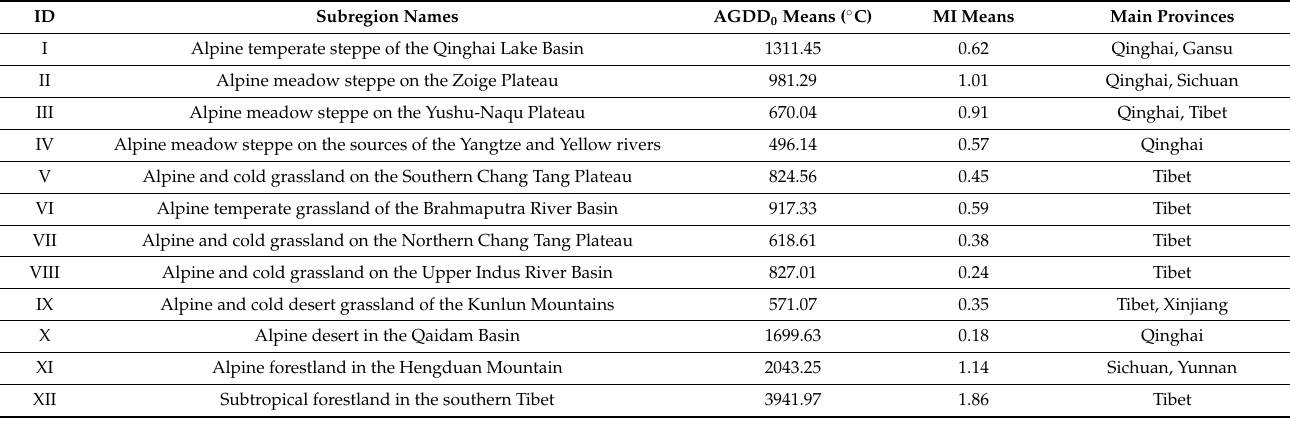
Table 1. Description of the Qinghai-Tibetan Plateau subregions. AGDD 0 : Annual accumulated temperature above 0 ◦ C. MI: Moisture index calculated by the ratio of the mean annual precipitation to the annual equilibrium